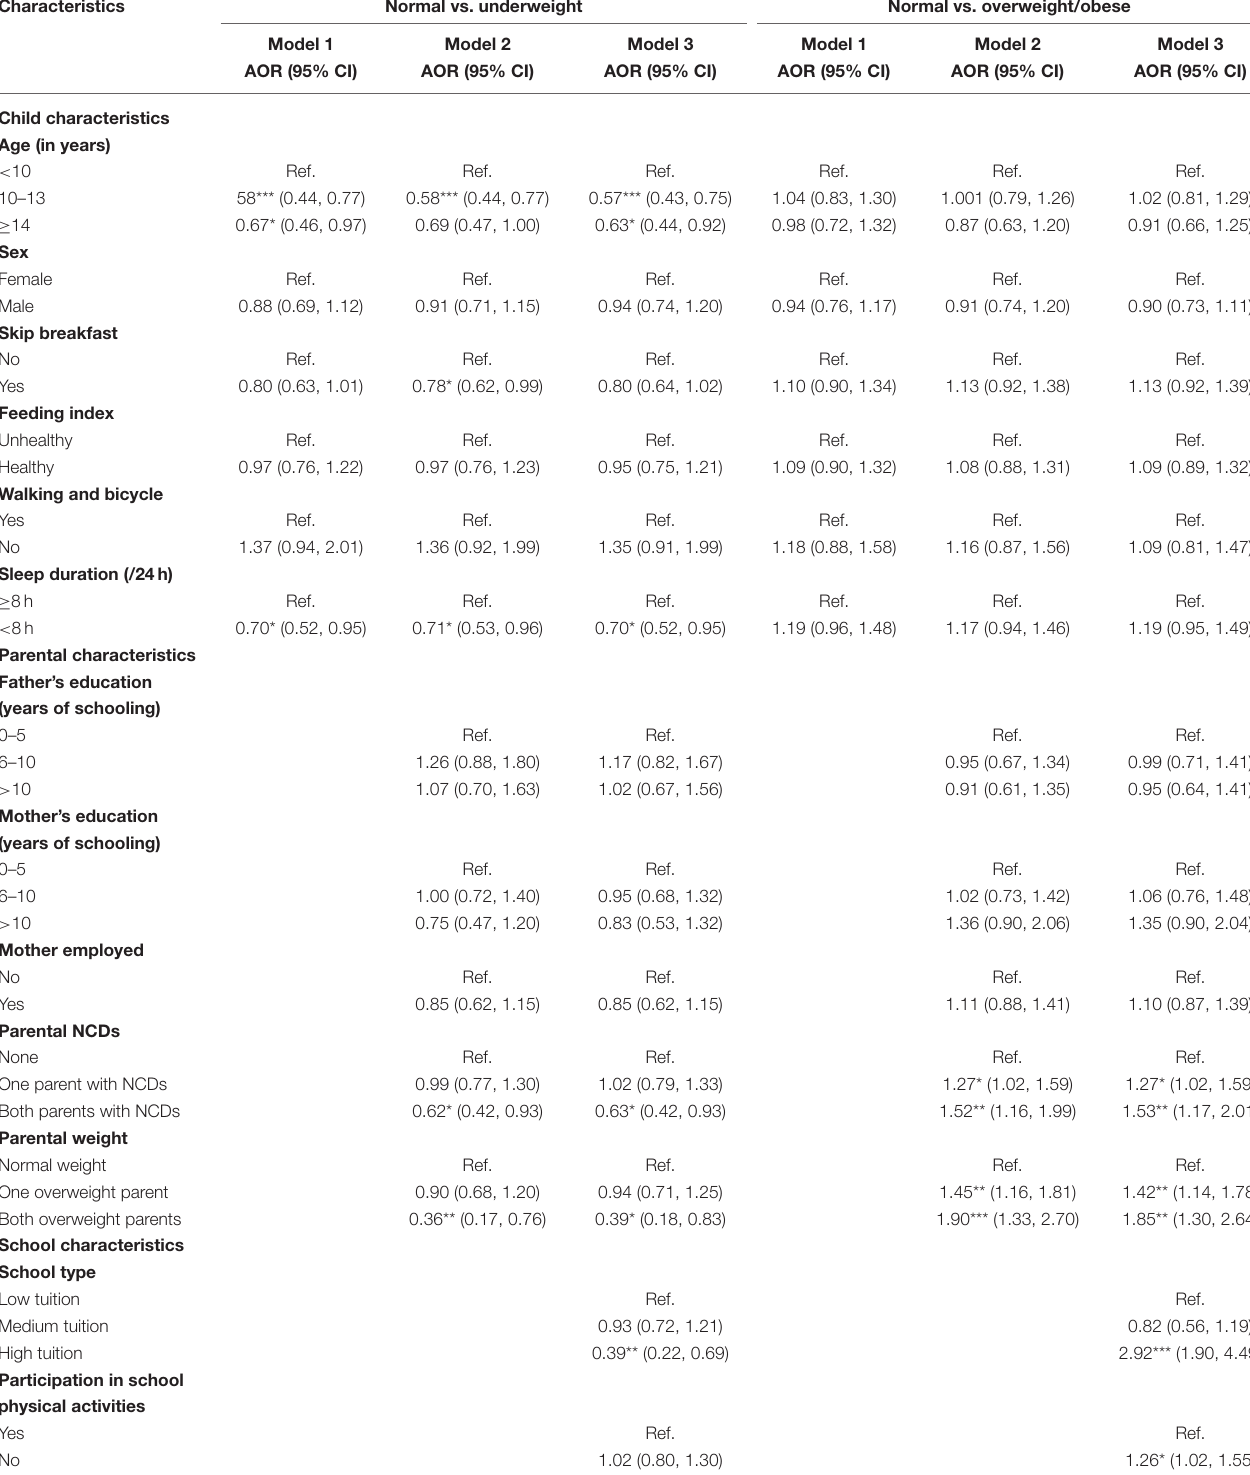
TABLE 4 | Determinants of underweight and overweight/obesity among school children.